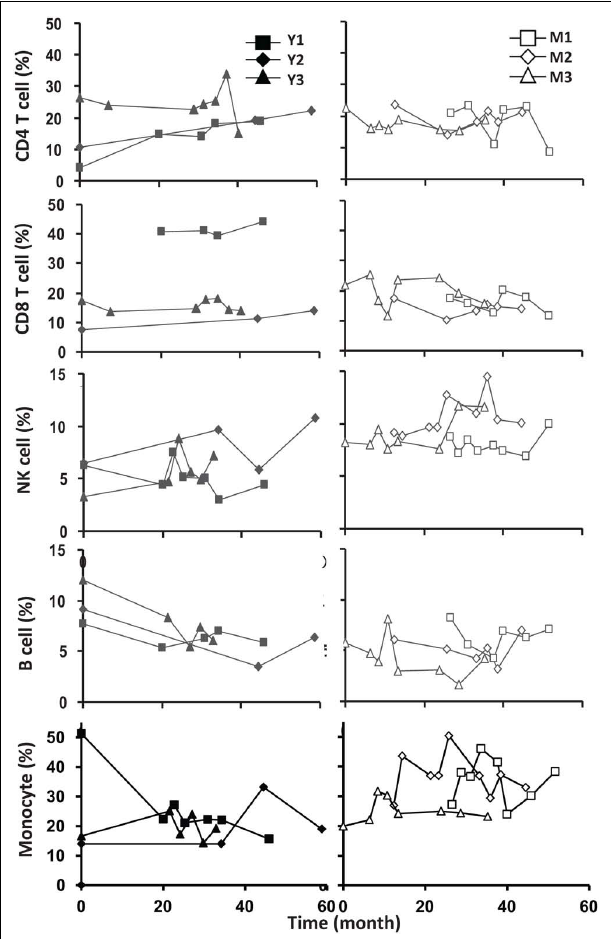
FIGURE 2 | Frequent luekapeheresis did not alter frequency of PBMC constituents. Donors underwent leukapheresis every other month and the relative percentages of componenT cell types were determined from PBMC by FACS analysis.Young donors (left panels) were compared with middle-aged donors (right panels). Starting from the top CD4, CD8, NK cell (CD16/CD56 + ), B cells (CD19 + ), and monocyte (CD14 + ) were examined. Time values on the abscissa correspond to the time values on the abscissa in Figure 1 .